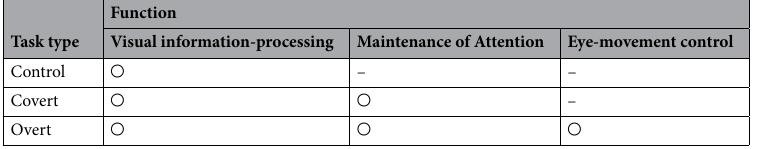
Table 1. Relationship between tasks and neural functions. A circle indicates that a neural function is required for a task